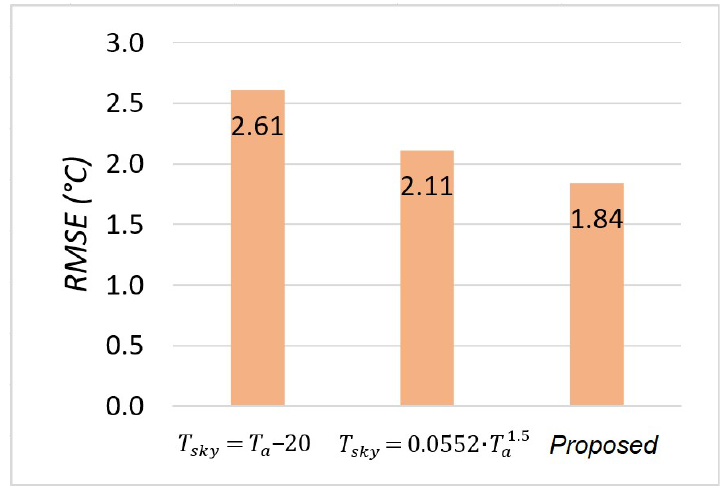
Figure 4. Temperature RMSE for different sky temperature models.